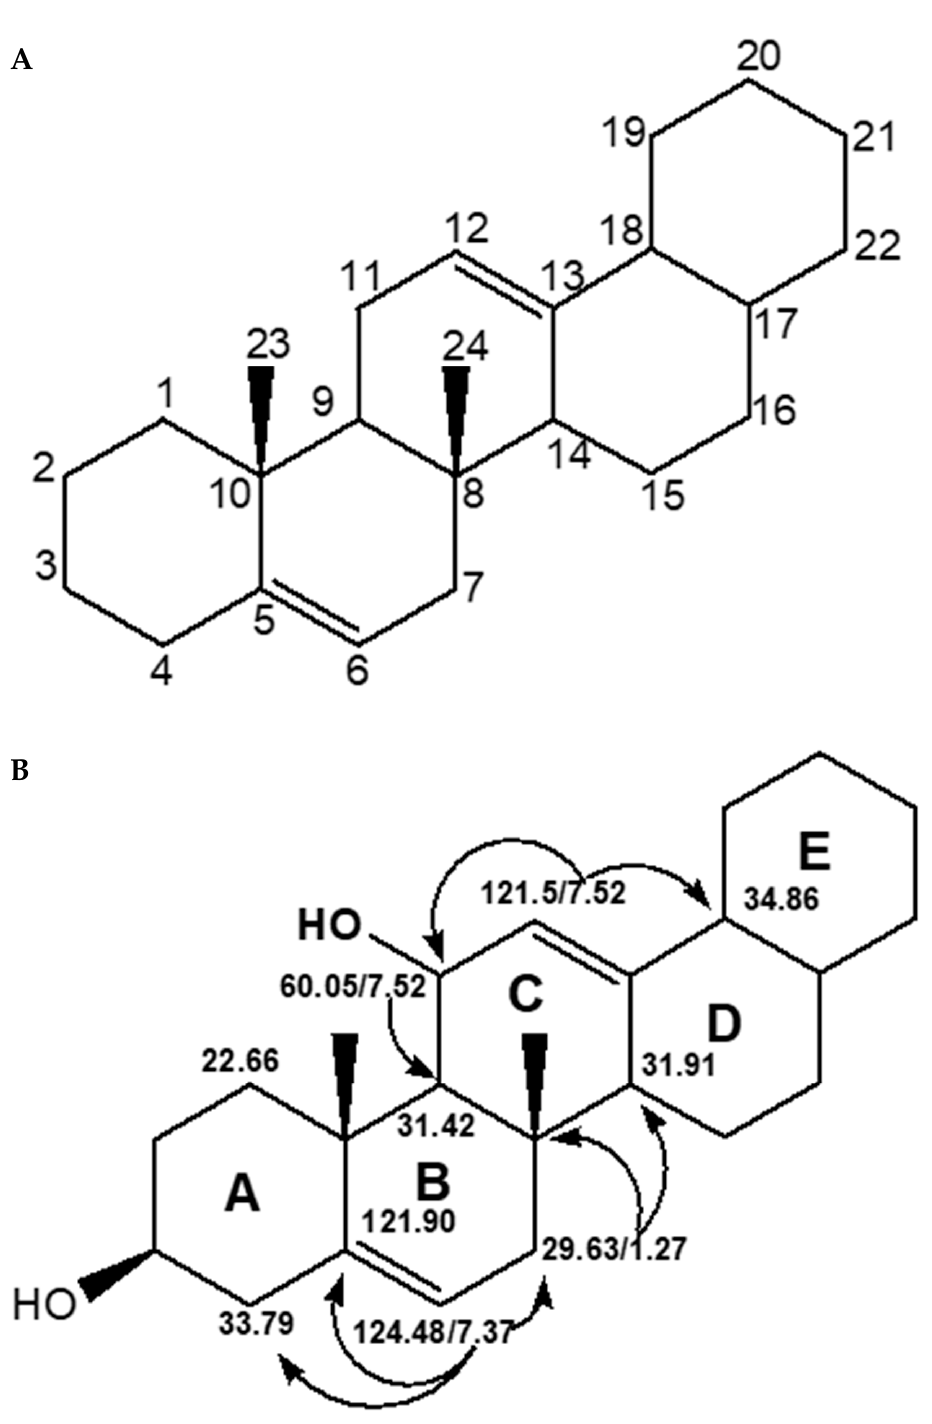
Figure 5. Skeletal structure of ( A ) HMBC connectivity of the different moieties ( B ) of Ra isolated from the hexane extract of M. oleifera leaves.